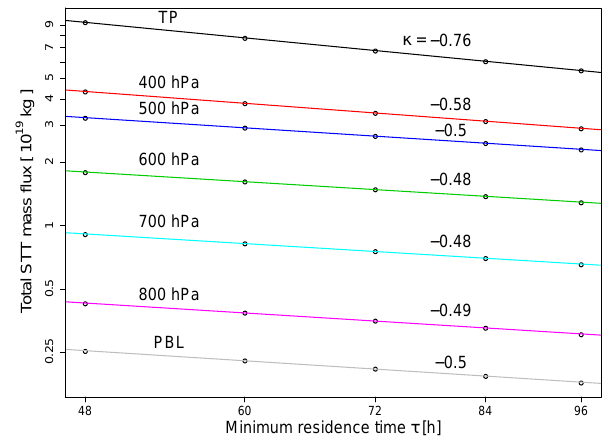
Fig. 21. Globally integrated STT mass flux across the tropopause, pressure surfaces from 400 to 800hPa, and into the PBL aver- aged for 1979–2011. Note the double-logarithmic scale. The flux decreases with increasing minimum residence time threshold τ as a power law (that is, the flux is proportional to τ κ ). The fitted ex- ponents κ ( R 2 > 0 . 995 for all fits) are listed adjacent to the corre- sponding